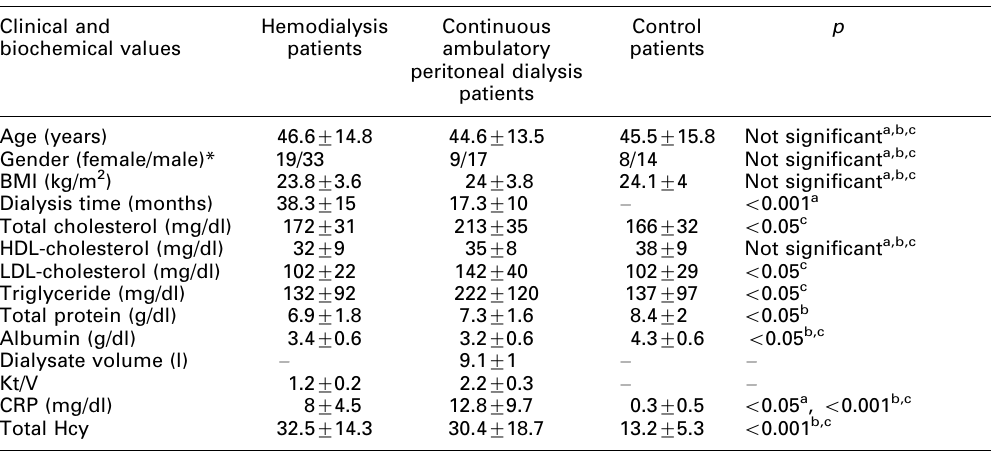
Table 2. Mean values of clinical and biochemical values of the groups Clinical and biochemical